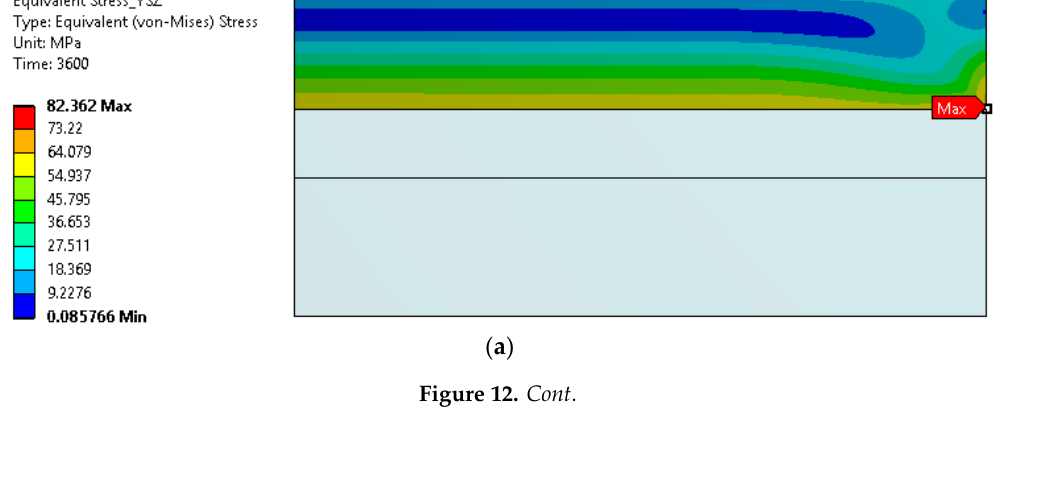
( b ) Figure 12. Temperature distribution in the coatings ( a ) during the heating cycle and ( b ) during the cooling cycle. A comparison of equivalent stress evolution in the YSZ layer in response to temperature in both cases is plotted in Figure 13. The results are extracted from the extreme node at the interface of YSZ and bond coat, indicated by “Max” in Figure 12. Figure 13. Comparison of equivalent stress of TBC with a bond coat made using APS and HVOF. In the case of a bond coat made using the HVOF process, the equivalent stress increases with a corresponding increasing temperature until 750 °C. The creep constants are defined to actuate at 750 °C, and thus a stress relaxation is observed once the temperature is beyond 750 °C. The relaxation in the case of TBCs made using APS is not as steep—it relaxes gradually until the end of the heating cycle. In addition, creep strain in the YSZ layer is plotted on the same location (Figure 14). It is 020040060080010001200 0100200300400500600700 0